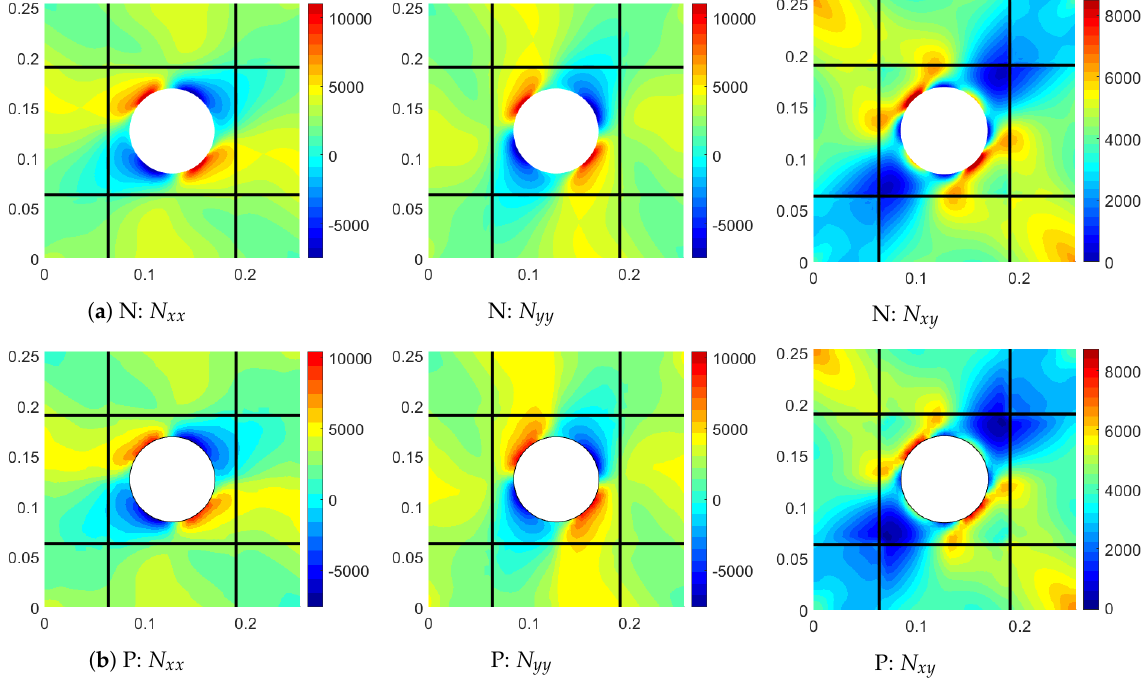
Figure 15. Comparison of stress resultants (unit: N/m) of the stiffened VAT laminates with a central hole under in-plane shear displacements. ( a ) N: NASTRAN results; ( b ) P: Present